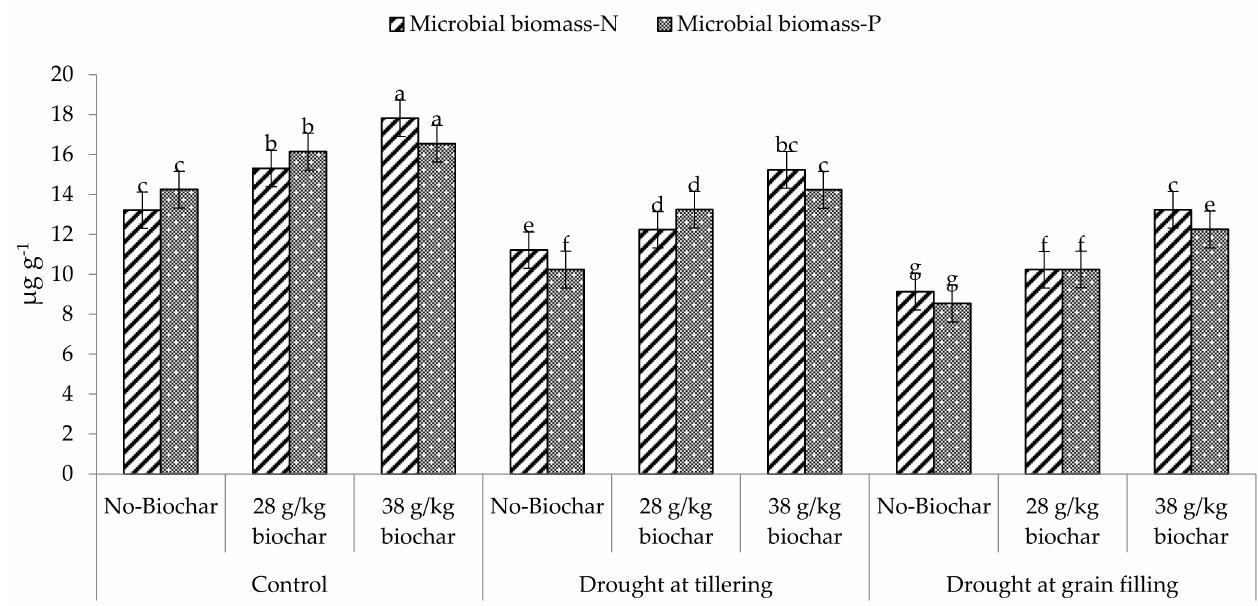
Figure 2. Effect of Biochar on Microbial biomass-N and Microbial biomass-P of soil under